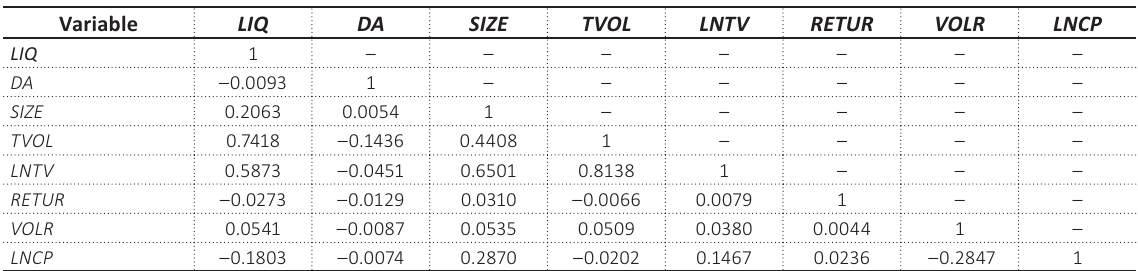
Table 2. Pearson correlation